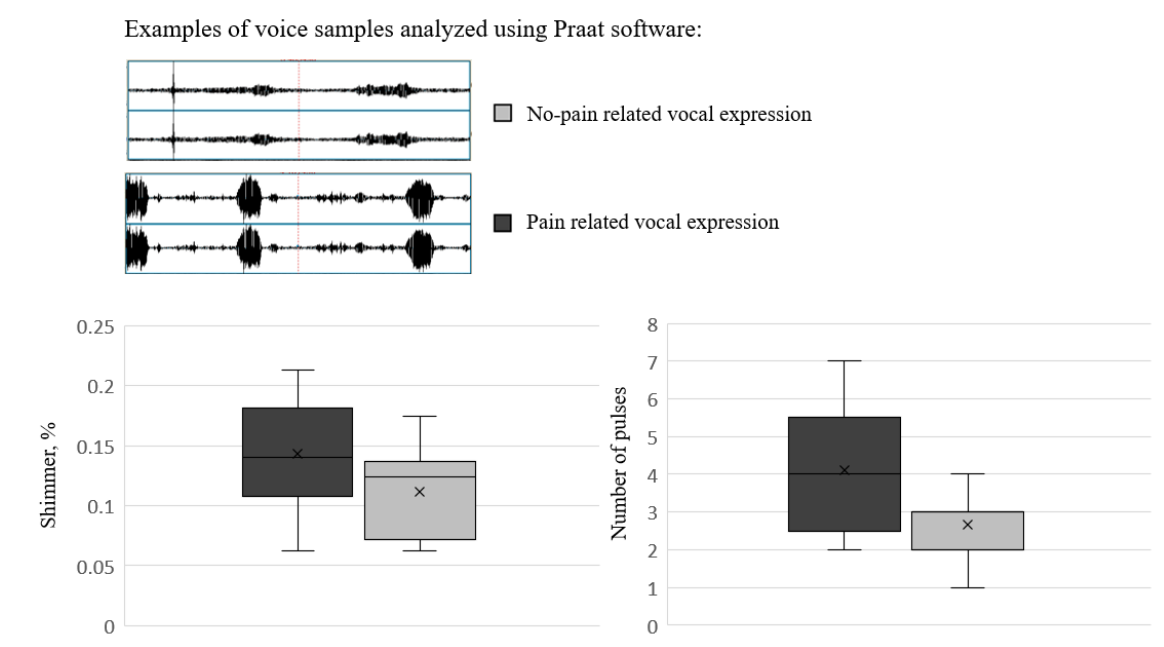
Figure 1. Results of Icht et al., 2021 [62]: Examples of the acoustic analysis of the voice recordings for pain- and no-pain related vocal expressions, and Box plots depicting the main findings: Shimmer level (%, the left panel bar plot), and number of pulses (the right panel bar plot ).